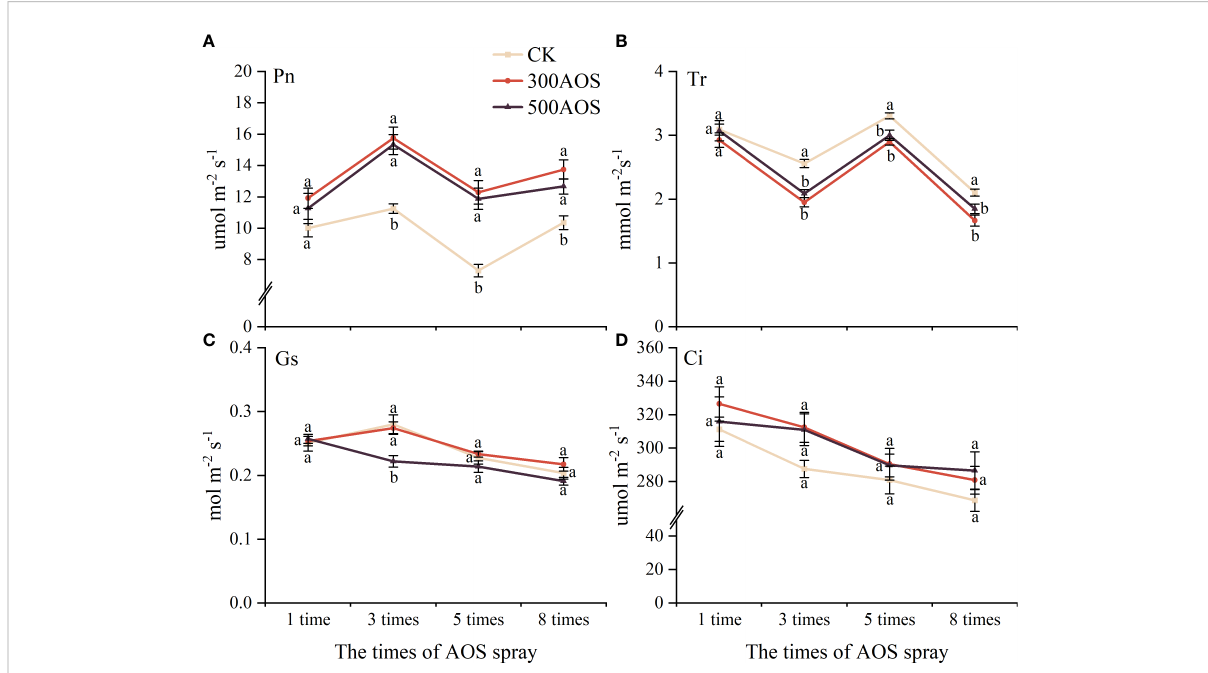
FIGURE 4 Effect of AOS treatment on photosynthesis in citrus leaves. Net photosynthetic rate (A) , transpiration (B) , stomatal conductance (C) and intercellular CO2 concentration (D) . Different lowercase letters indicate signi fi cant differences among the treatments, based on the Duncan test ( p < 0.05, n = 4).